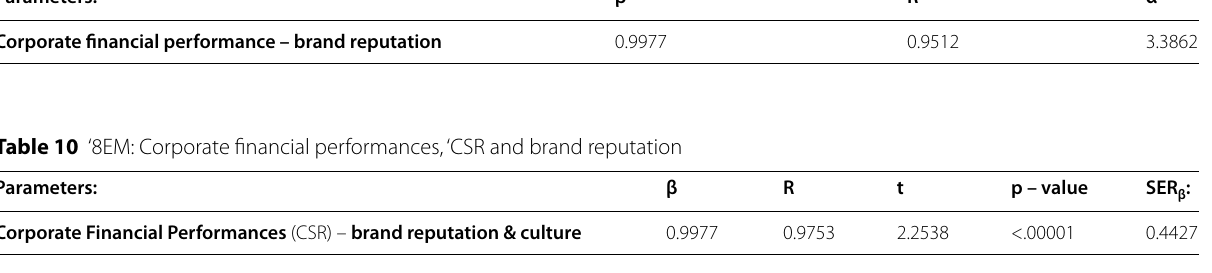
Table 9 SEM on CSR, corporate financial performance and brand relationship Parameters: β